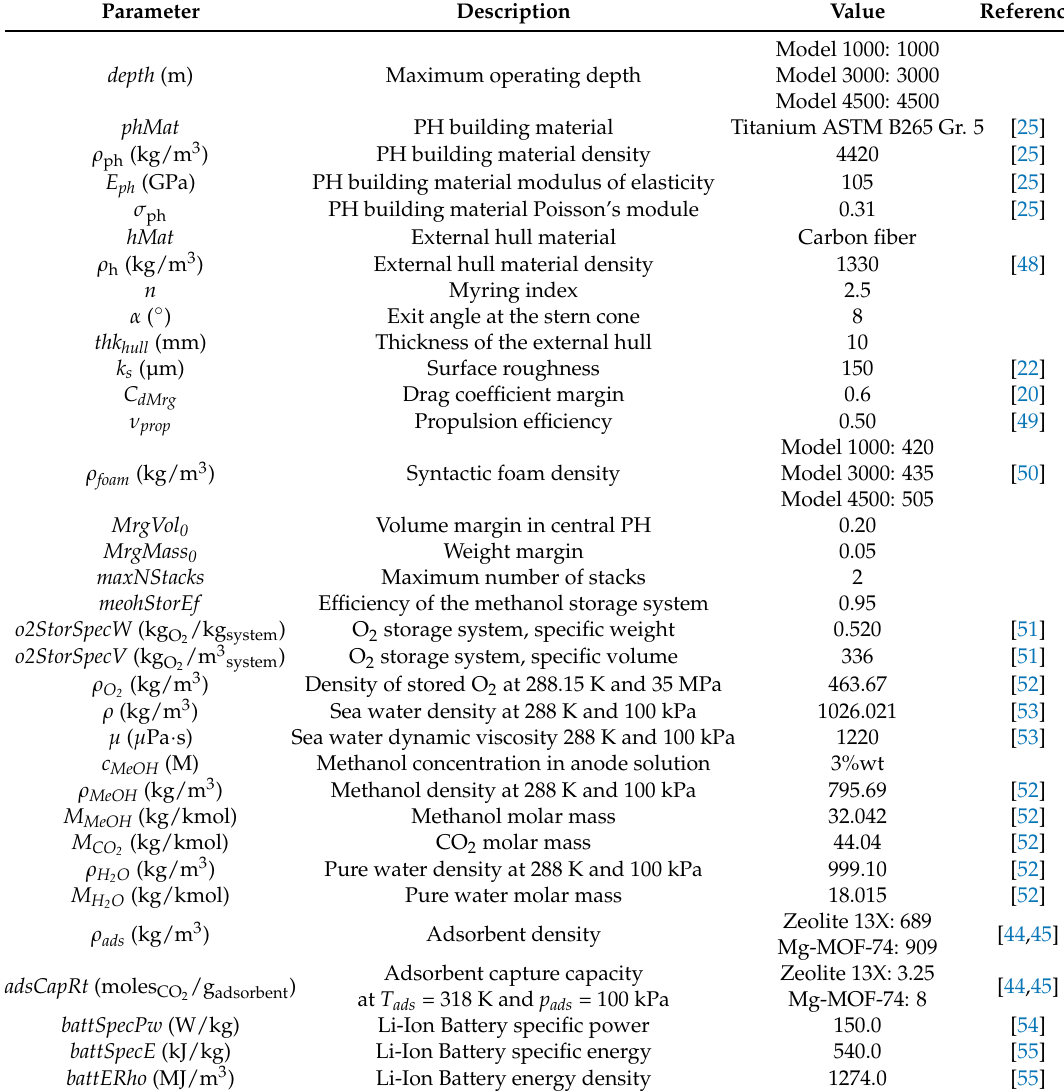
Table 4. Input parameters of the genetic algorithm (GA). PH, pressure